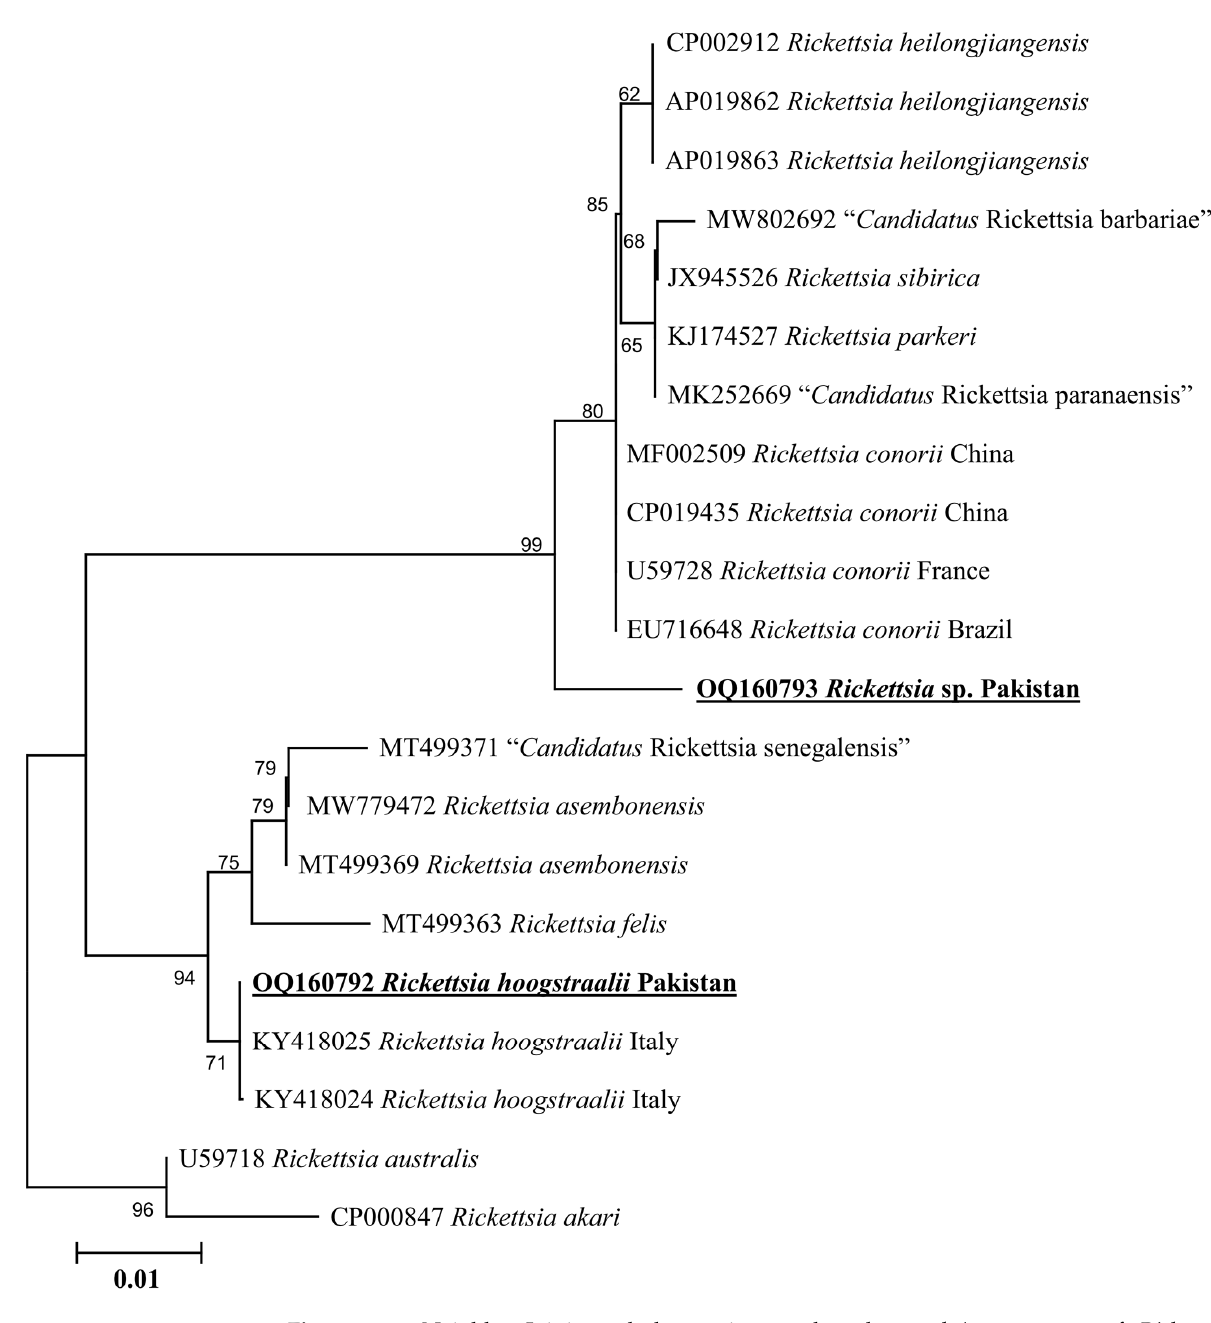
Figure 5. Neighbor-Joining phylogenetic tree based on gltA sequences of Rickettsia sp. and R. hoogstraalii . The gltA sequences of Rickettsia australis and Rickettsia akari were employed as an outgroup. All sequences have been denoted by their GenBank accession numbers, followed by species name and country name. The bootstrap values (1000 ‐ replications) are shown at each node. The sequences (OQ160793 and OQ160792) of the present study have been marked with bold and underlined fonts.